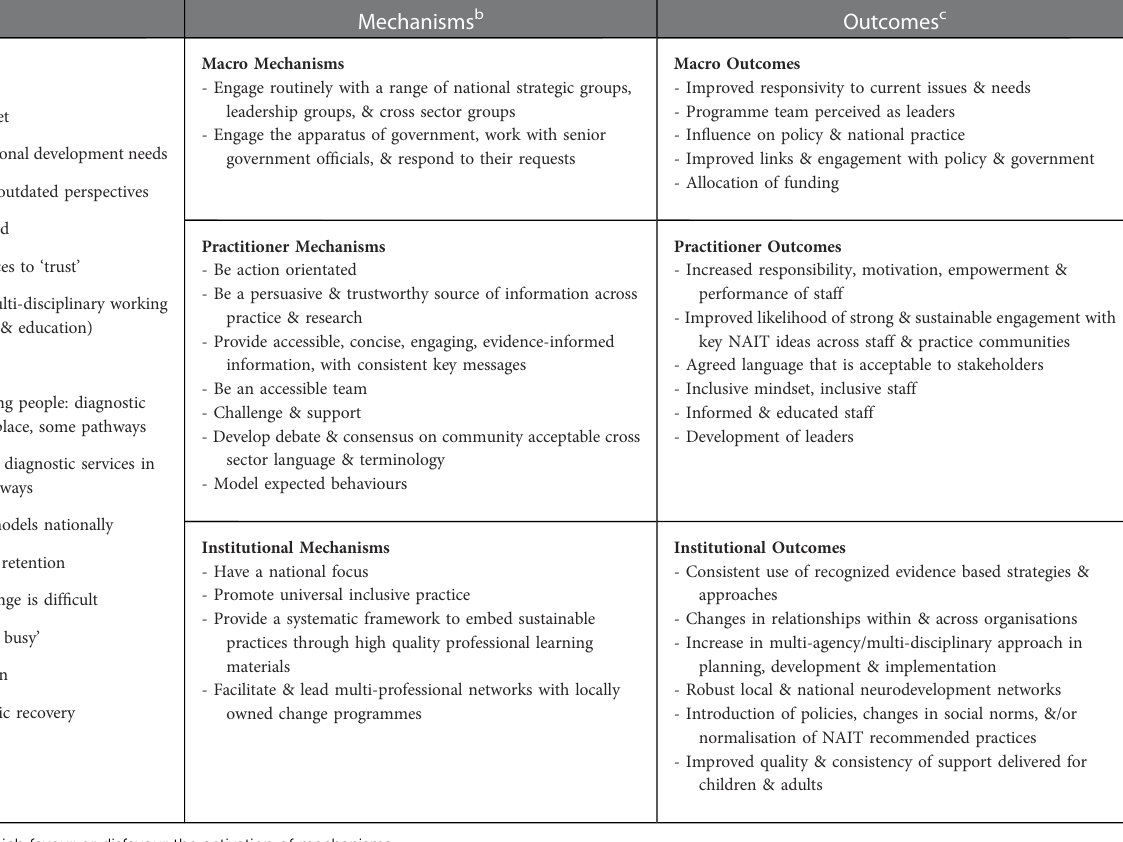
TABLE 5 Realist matrix for the NAIT programme (programme